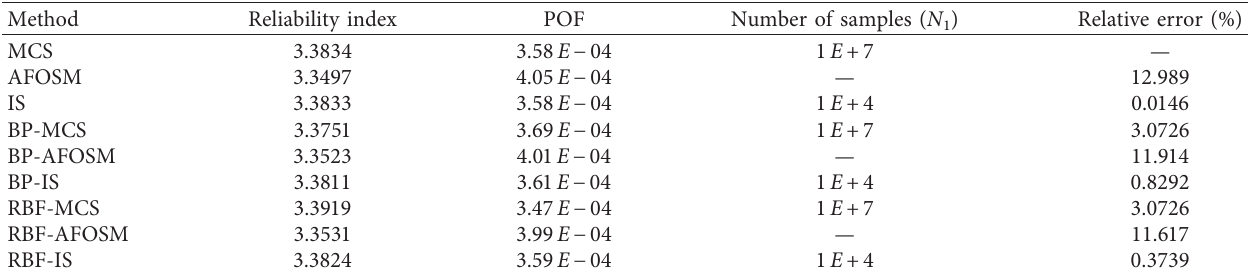
Table 1: Comparison of the reliability index and POF from different reliability analysis methods with an ANN sample size of 100.